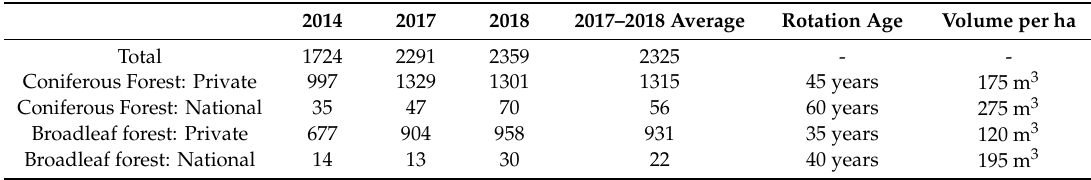
Table 3. Annual harvesting performance: by species and ownership.